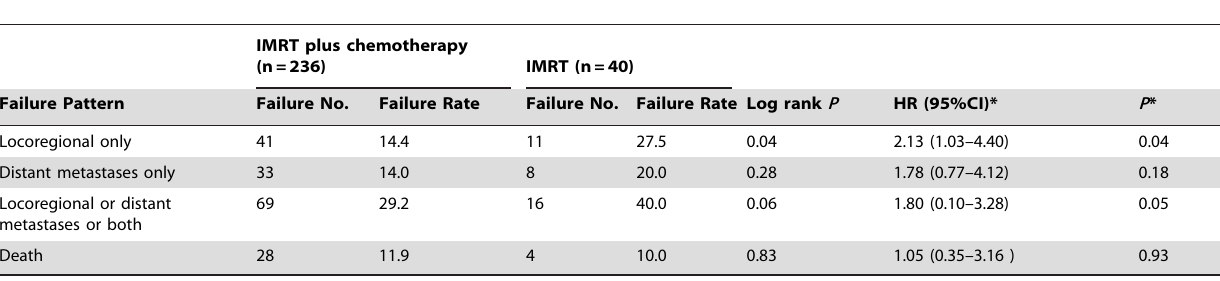
Table 2. Patterns of disease failure in patients treated with IMRT alone versus combination of IMRT and chemotherapy.